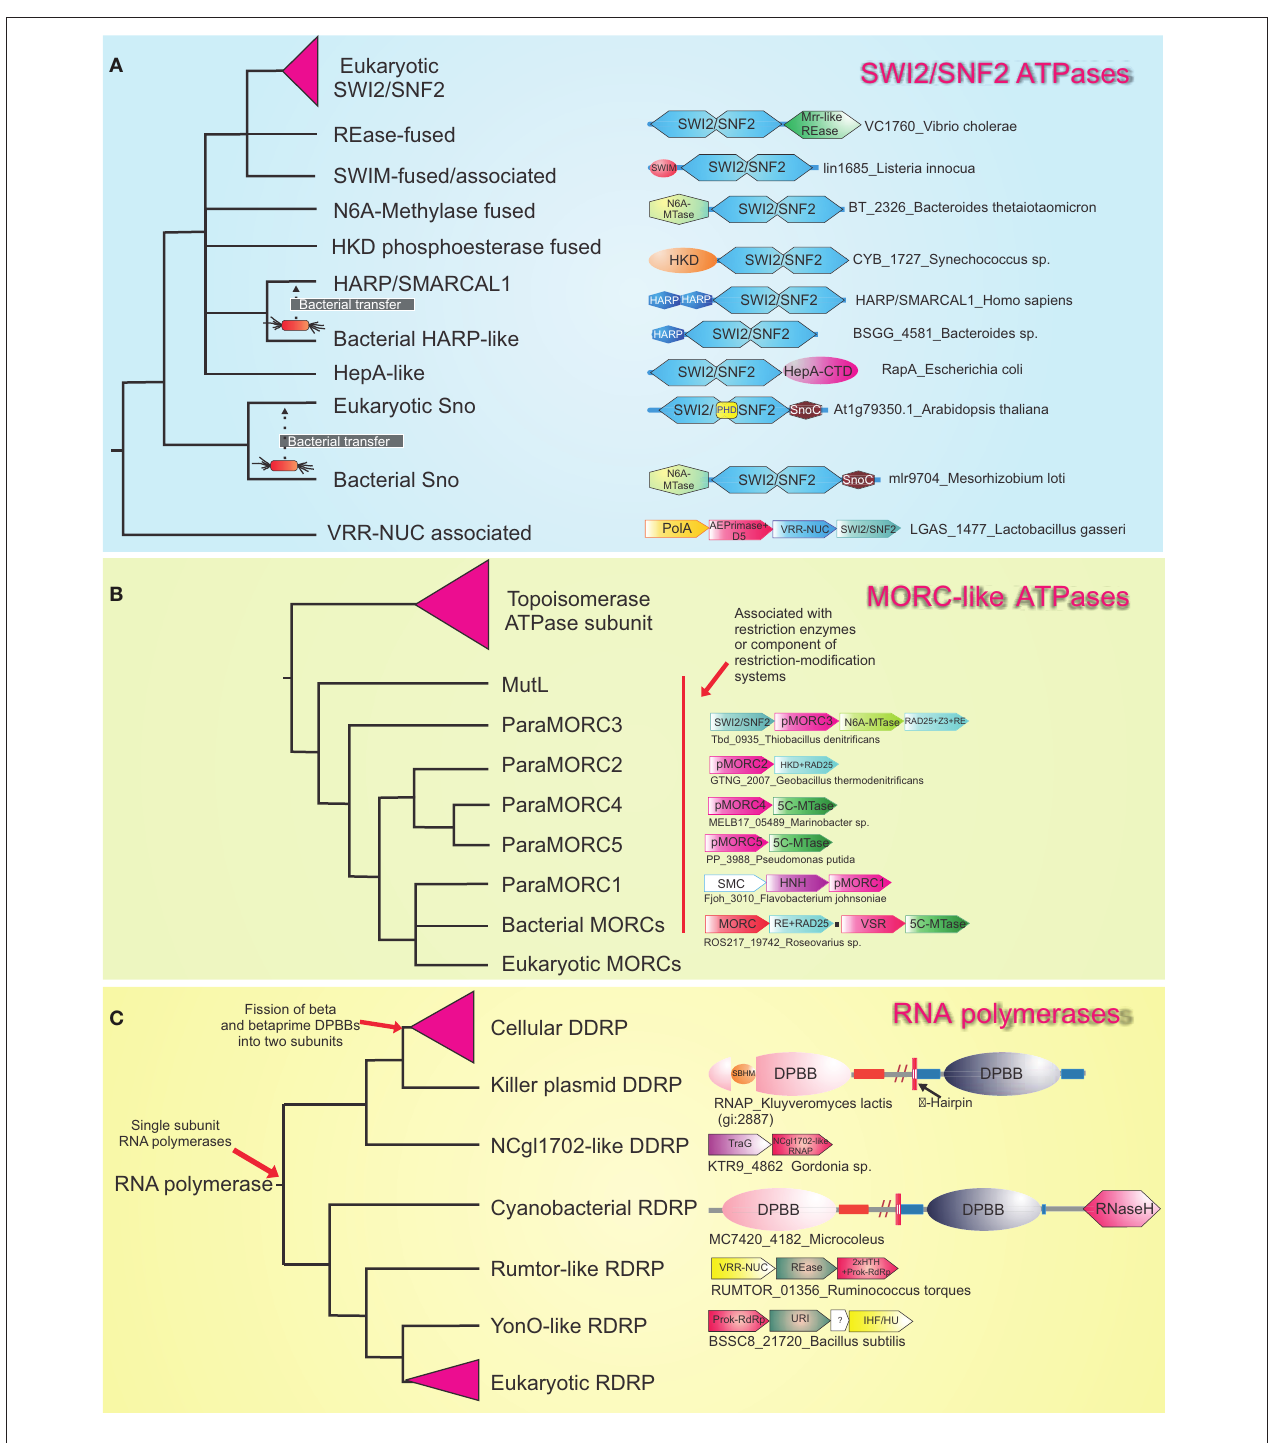
FIGURE 3 | Evolutionary relationships of various families of enzymes illustrating the origin of eukaryotic versions within radiations of systems involved in inter- and intra-genomic conflicts. Reconstructed phylogenetic trees are shown for (A) The bacterial radiation of the SWI2/SNF2 ATPases. (B) MORC-like ATPases and (C) The Double-psi beta barrel containing RNA polymerases. Certain clades with multiple families such as the eukaryotic SWI2/SNF2 ATPases, the Topoisomerase ATPase subunits, the cellular DDRP and eukaryotic RdRPs are collapsed into triangles